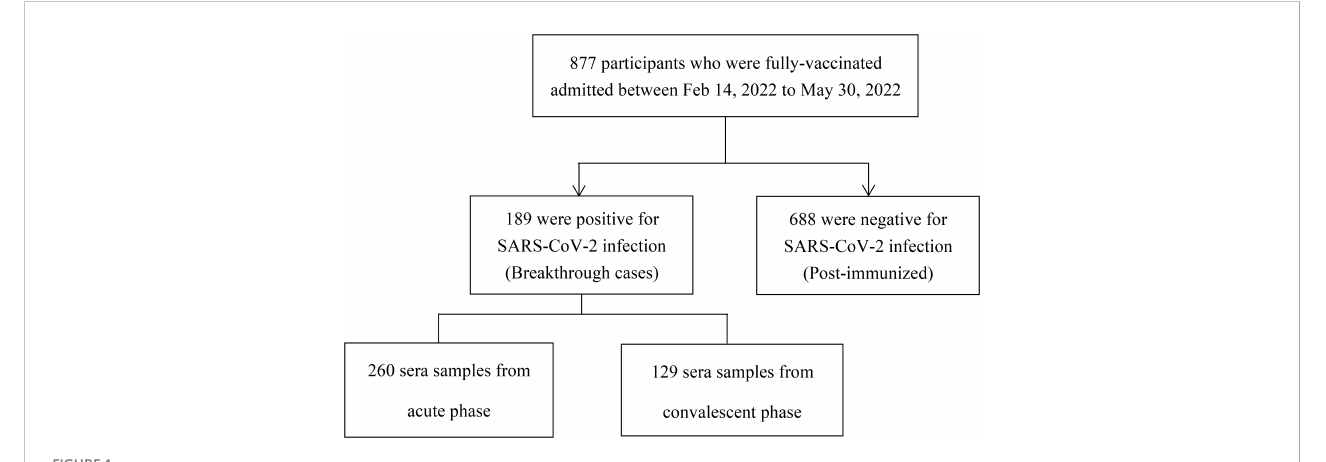
FIGURE 1 Flow chart of study